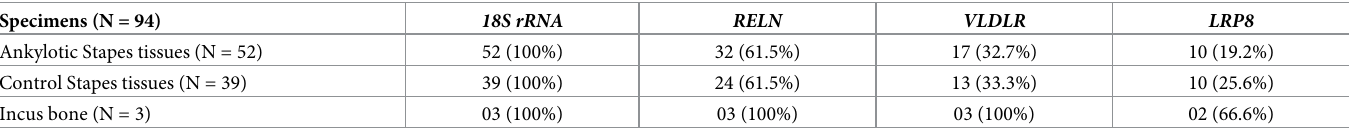
Table 3. Expression of RELN , VLDLR , LRP8 and 18S rRNA genes in otosclerotic tissues and in tissue specific controls. Specimens (N = 94) 18S rRNA RELN VLDLR LRP8 Ankylotic Stapes tissues (N = 52) 52 (100%) Control Stapes tissues (N =